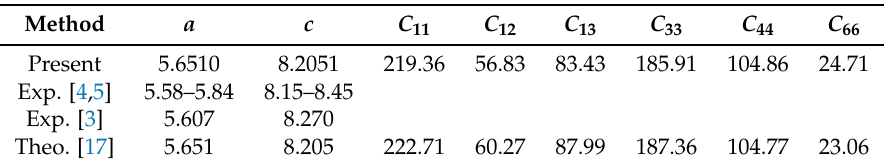
Table 1. Calculated lattice constants a , c (in Å) and elastic constants (in GPa) of Ti 4 Nb 3 Al 9 at zero pressure.